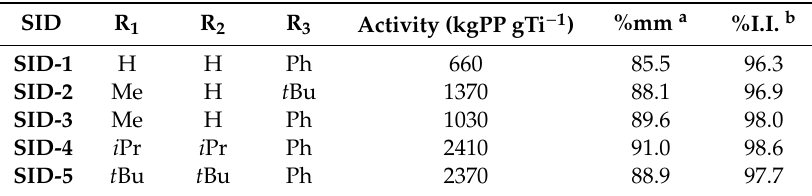
Figure 1. Chemical structure of salicylate donors with di ff erent substituent groups at R 1 , R 2 , and R 3 positions. Table 1. Salicylate donors (SID) with di ff erent substituent groups at R 1 , R 2 and R 3 positions and experimental data [16].